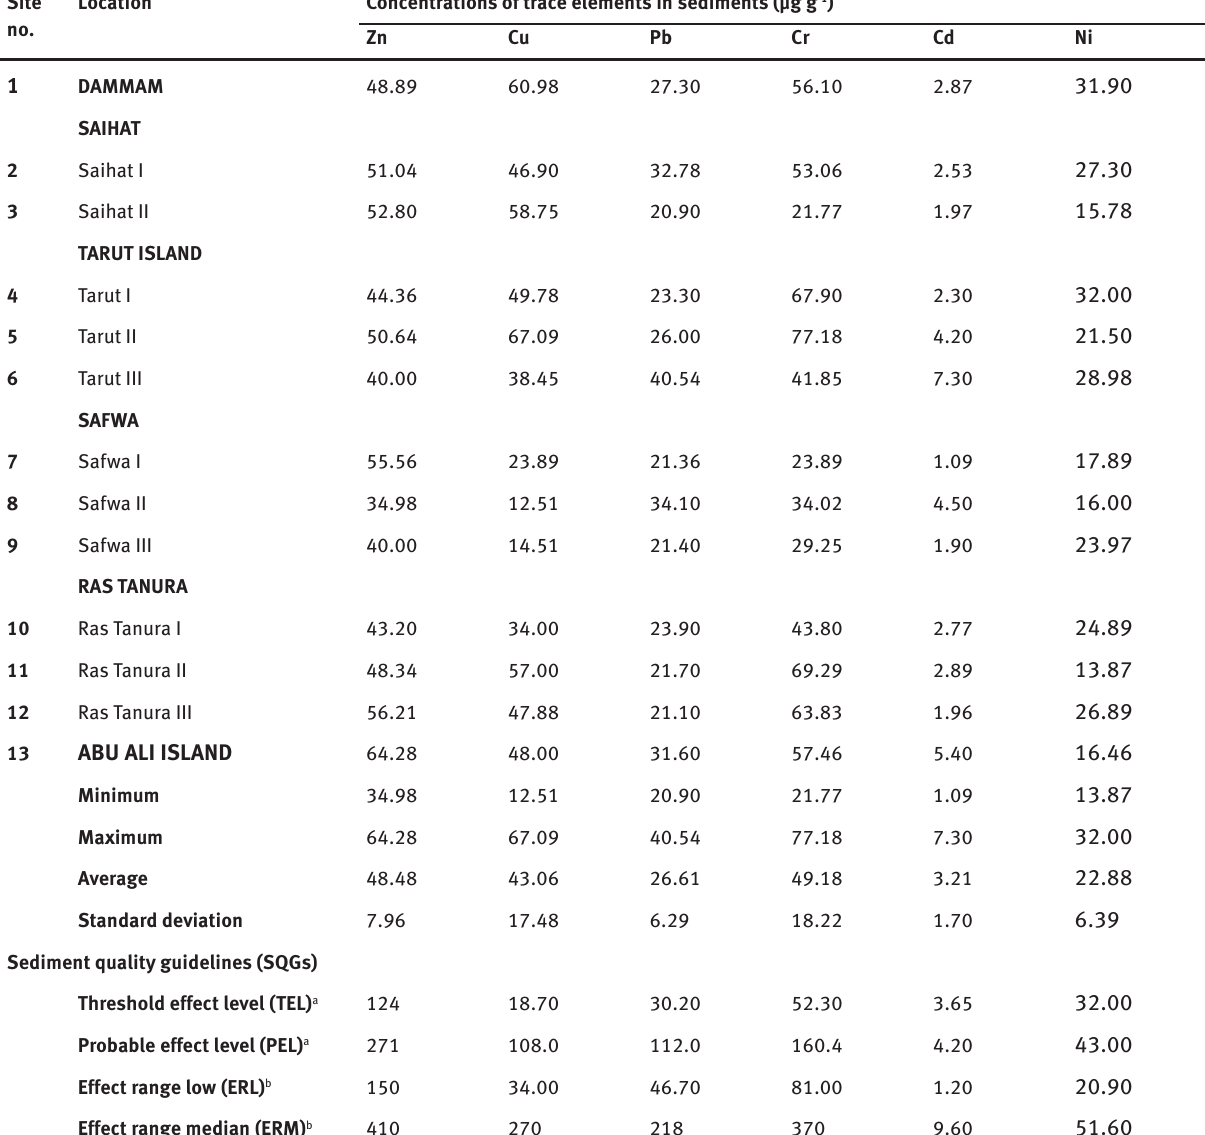
Table 2: Spatial distribution of trace elements (μg g -1 ) in surface sediments and sediment quality guidelines along the west coast of the Arabian Gulf, Saudi